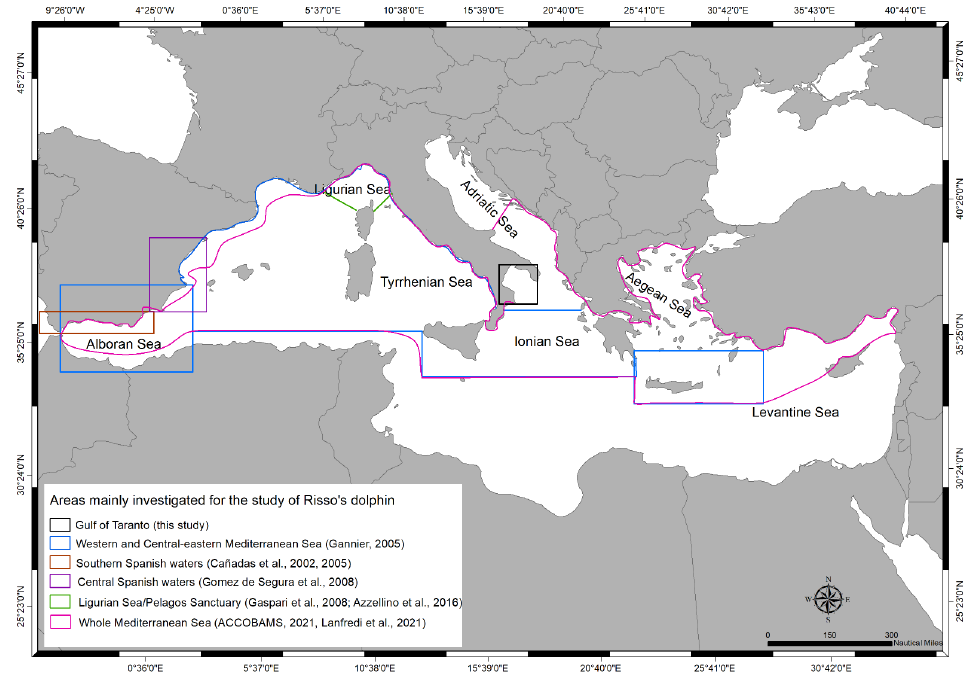
Figure 1. Map of areas monitored in the Mediterranean over time to study Risso’s